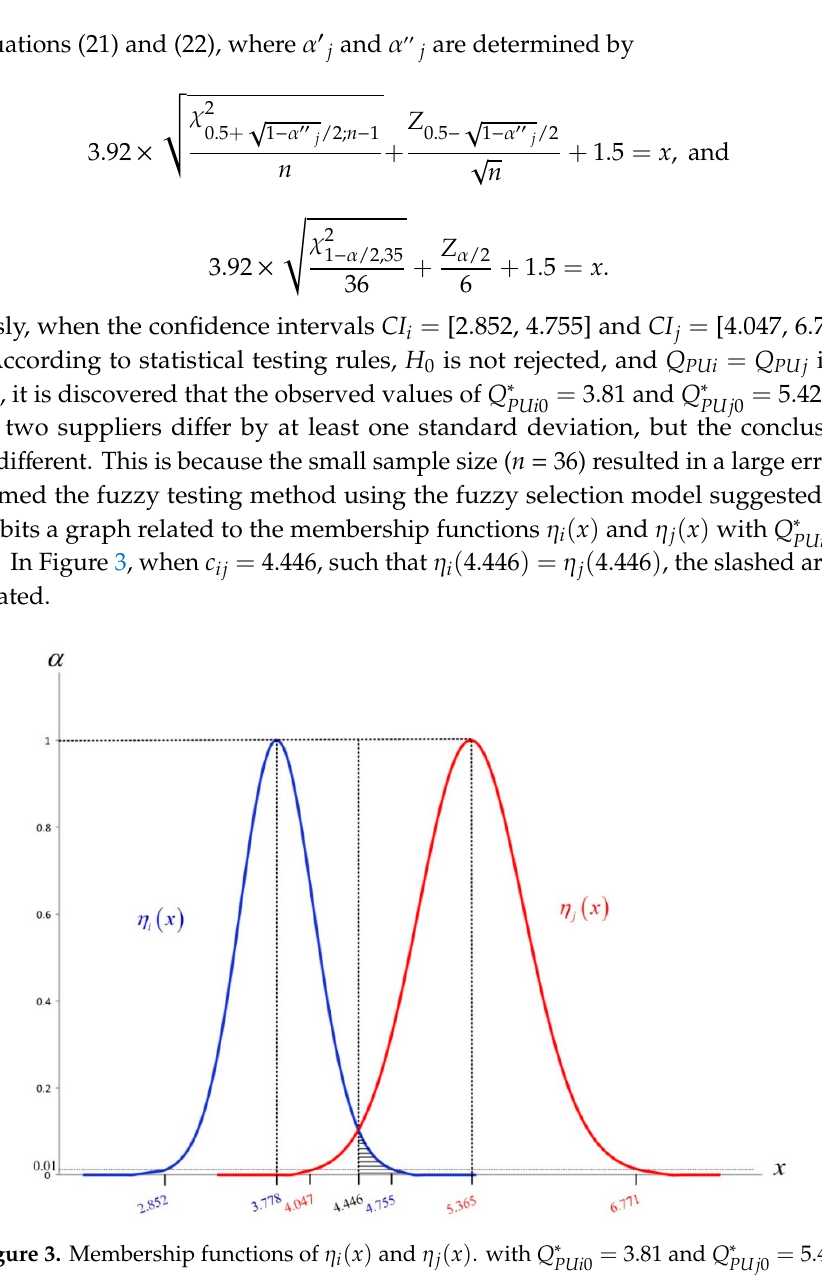
Figure 3. Membership functions of